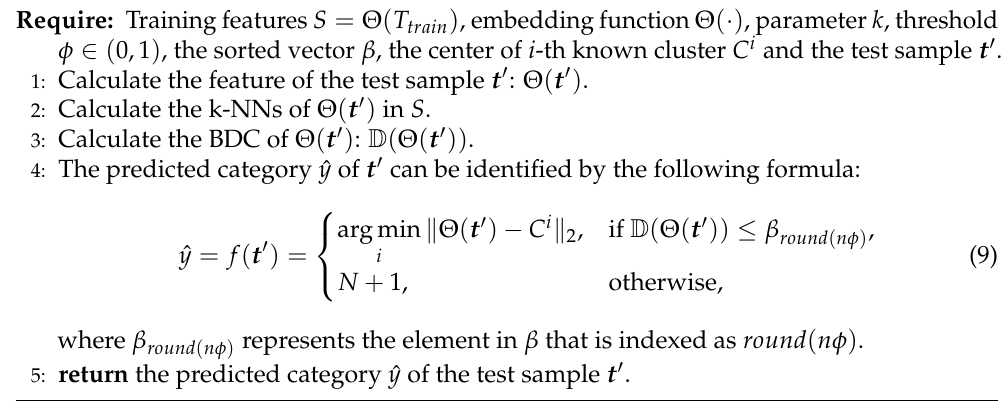
Algorithm 2 Identification